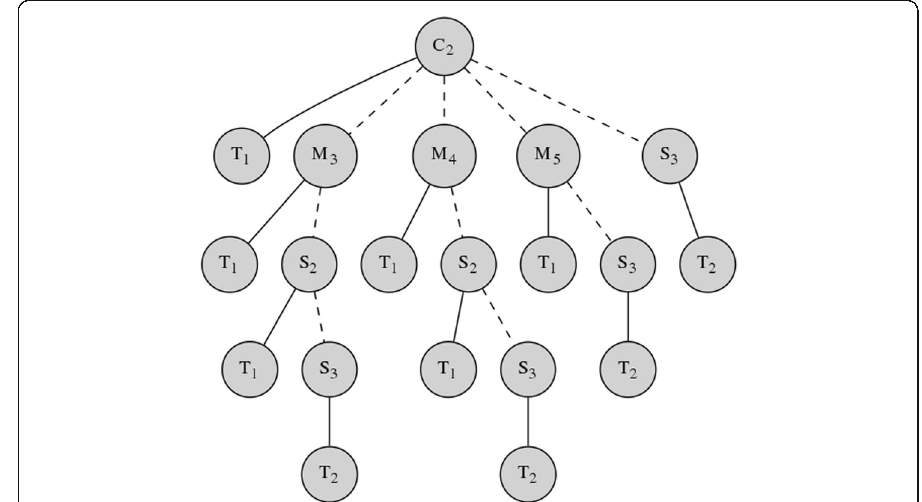
Fig. 2 An interdependency graph derived from topological